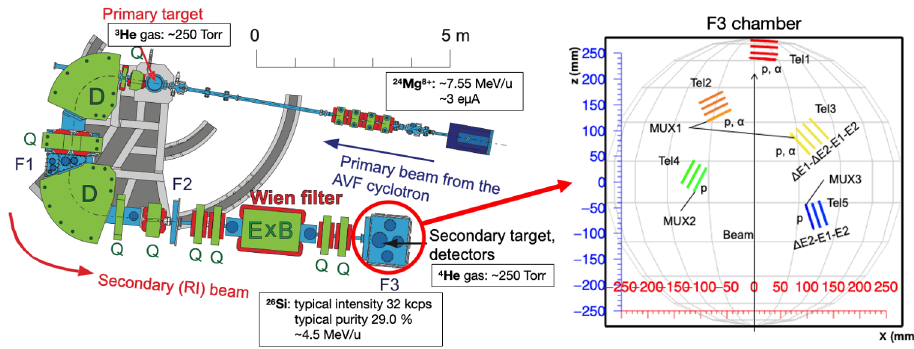
Figure 1. The left part shows the structure of CRIB facility and the parameters of the beam and the target. The right part shows the setup of the detectors in the target chamber. Note that the beam direction is from bottom to top. The three lower angle telescopes (Tel1, Tel2 and Tel3) consisted of two single- sided silicon strip detectors (SSSD) and two single-pad silicon detectors (SSD) and the two higher angle telescopes (Tel4 and Tel5) consisted of one double-sided silicon strip detector (DSSD) and two SSDs.